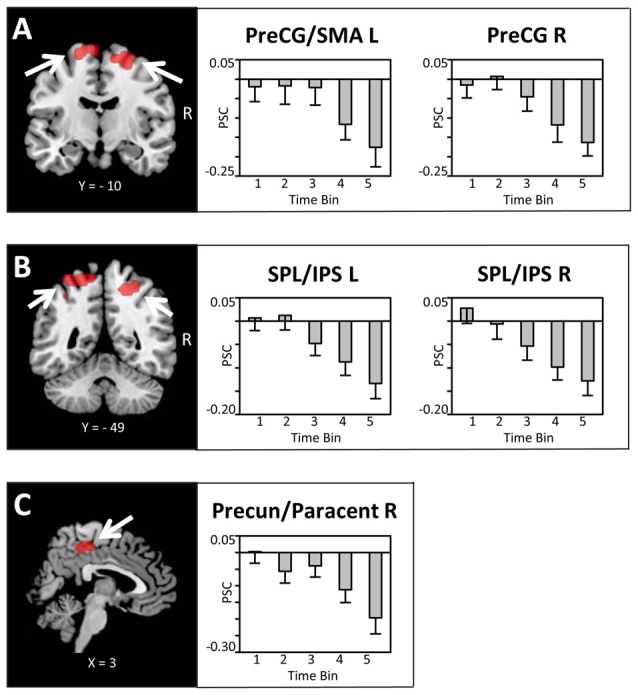
Brain sections and extracted PSC (mean ± SEM) illustrating the modulation in BOLD activity in (A) the supplementary motor cortex (SMA)/PreCG, (B) superior parietal lobule/intra-parietal sulcus (SPL/IPS) and (C) the Precun/Paracentr proportional to the amount of water ingested. Statistical maps are thresholded with a cluster-defining voxel-level threshold of p < 0.001 (uncorrected) and a cluster-level threshold of p < 0.05 (FWE-corrected). Abbreviations: SMA, supplementary motor cortex; PreCG, pre-central gyrus; SPL, superior parietal lobule; IPS, intra-parietal sulcus; Precun, precuneus; Paracentr, paracentral lobule.